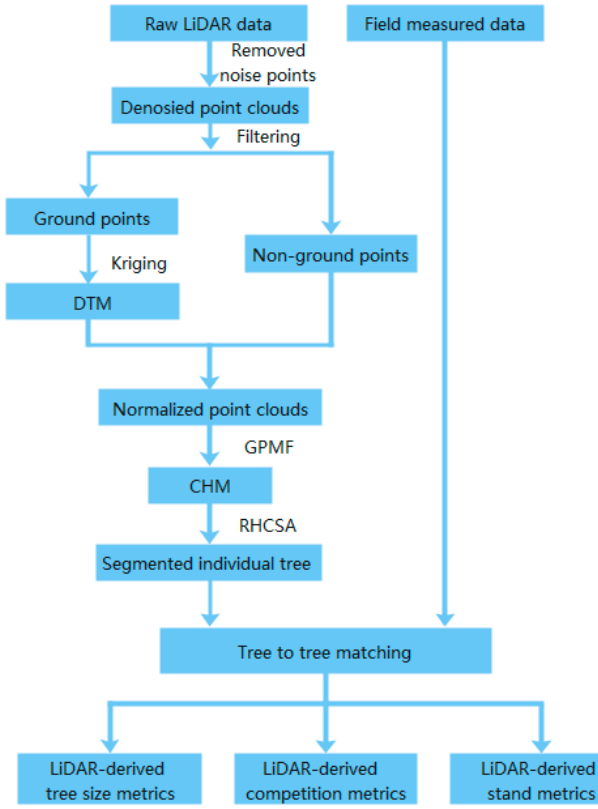
Figure 2. Flow chart showing acquisition processes of UAV-LiDAR.